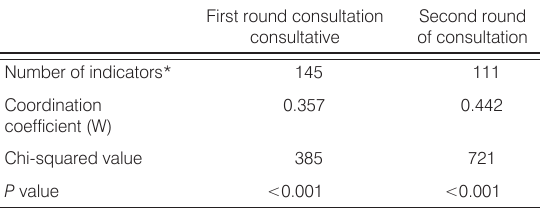
Table 1. The experts’ opinion coordination